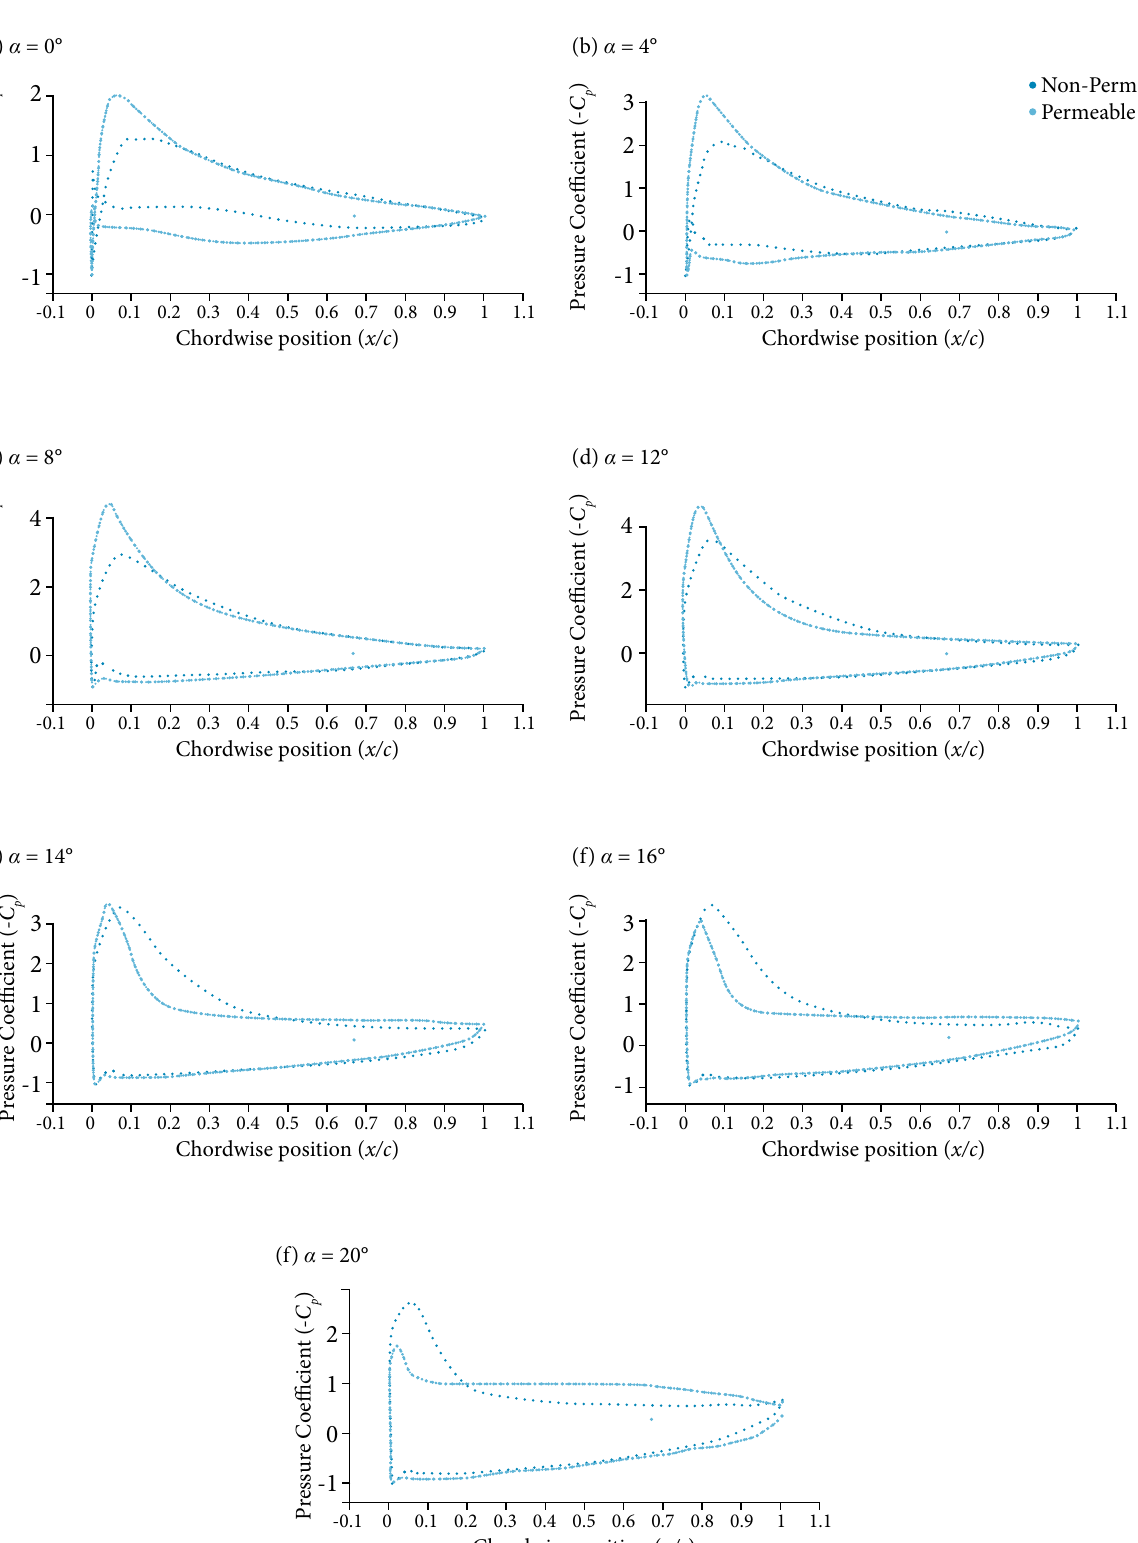
Figure 12. Pressure coefficient distribution for a permeable and nonpermeable airfoil at various angles of